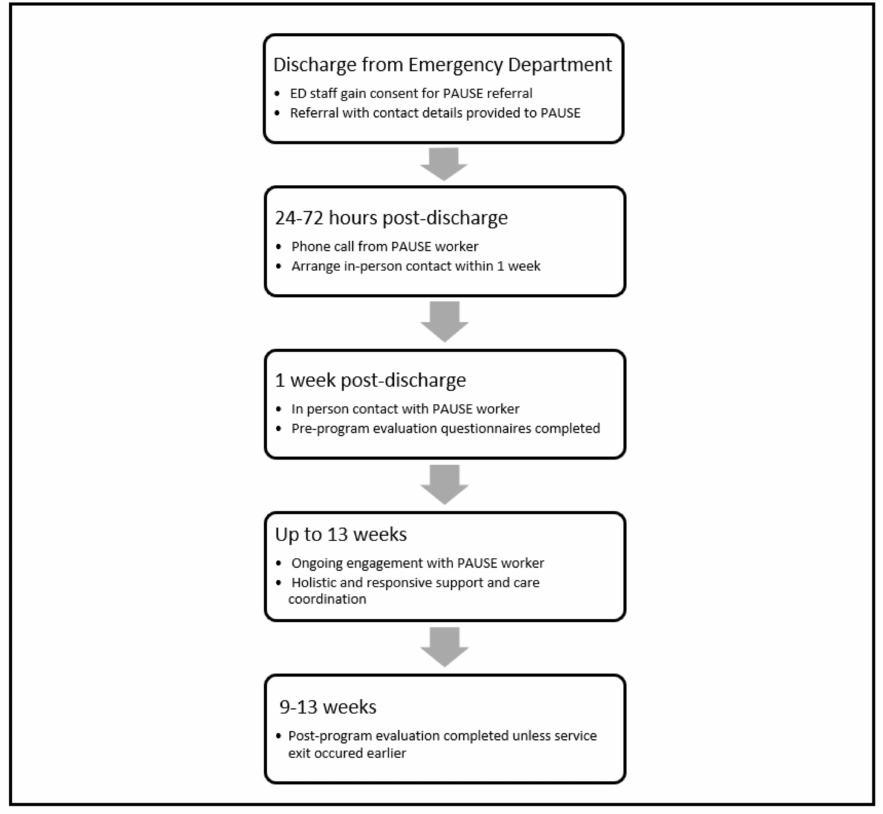
Figure 1. PAUSE pilot program